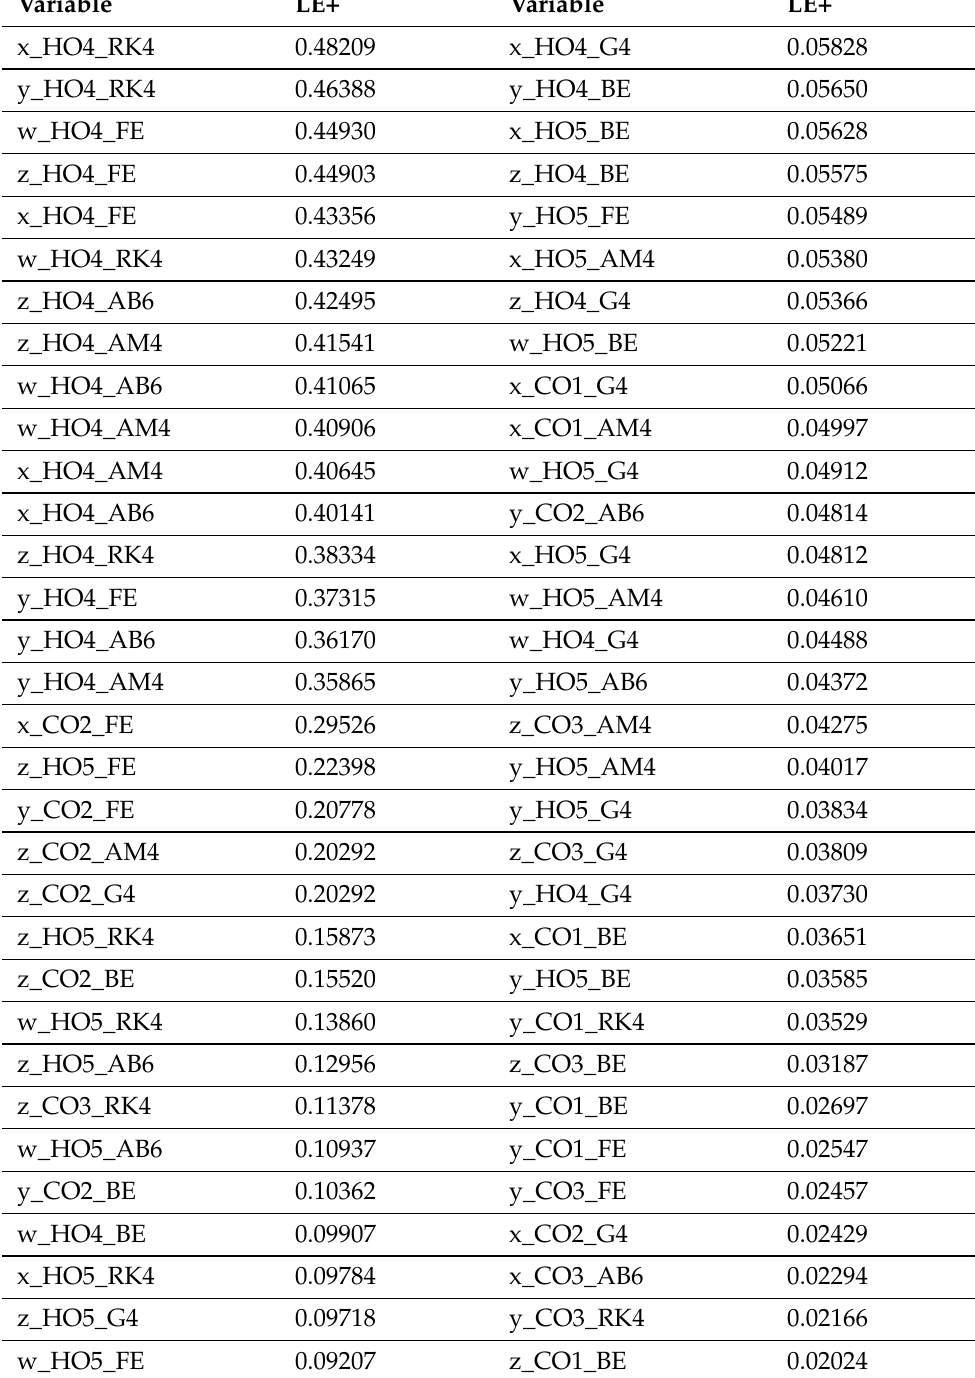
Table 4. LE+ (ordered from the highest to the lowest) evaluated by time series analysis (TISEAN) for each state variable of the five oscillators given in Table 1, and for each numerical